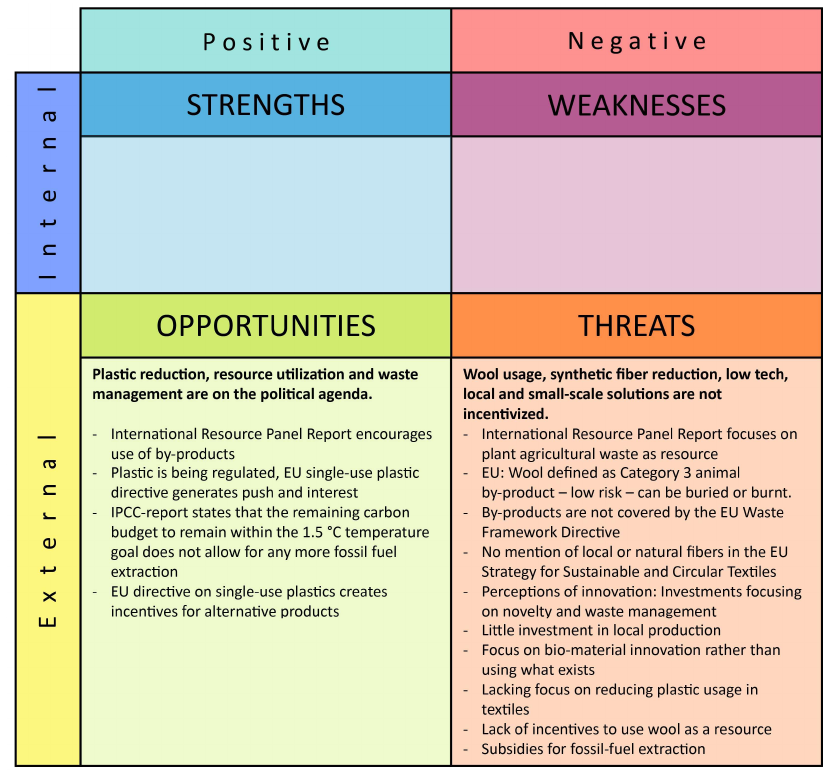
Figure 7. SWOT—Regulations and policy affecting coarse wool.